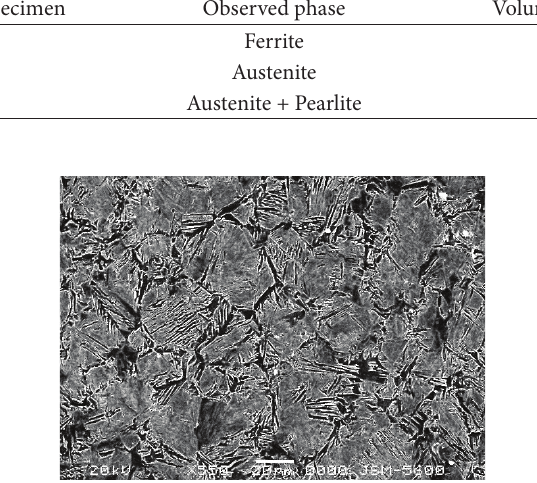
Figure 3: SEM micrograph of specimen C.